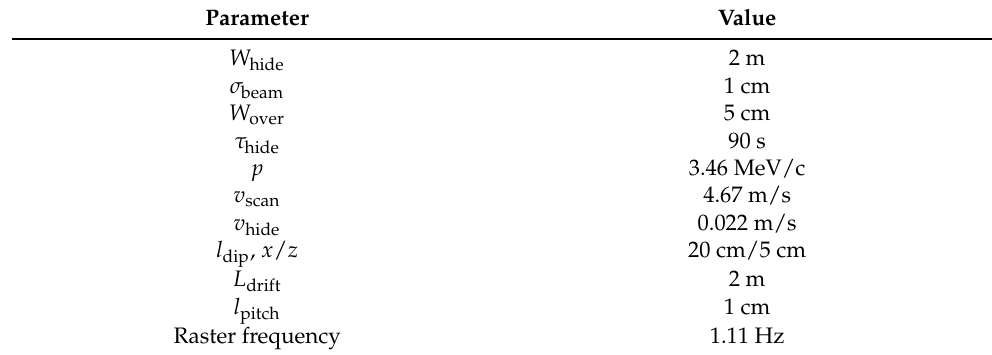
Table 1. Table of the assumed system design parameters for the proposed raster